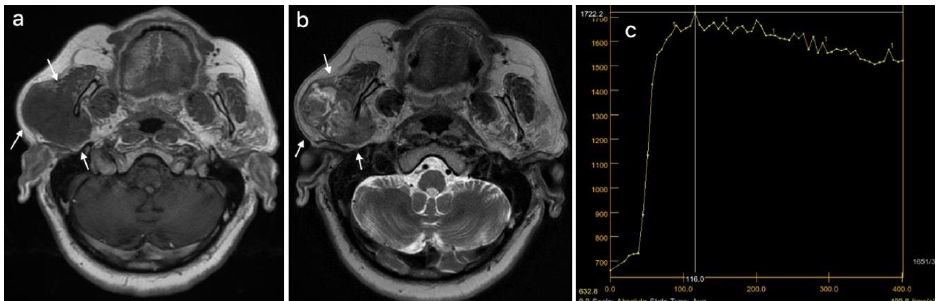
Figure 5. Malignant tumor of the right parotid gland (white arrows): ( a ) T1WI sequence showing an inhomogeneous hypointense signal in the tumor, with infiltrative borders; ( b ) T2WI sequence also showing an inhomogeneous signal, with central necrotic areas; ( c ) DCE-MRI showing a type C TIC curve .